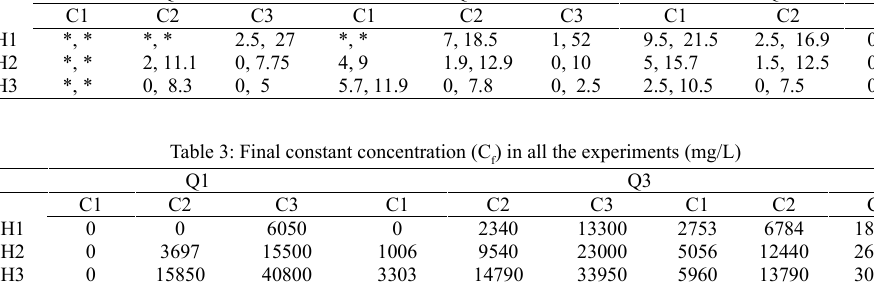
Table 2: The values of T